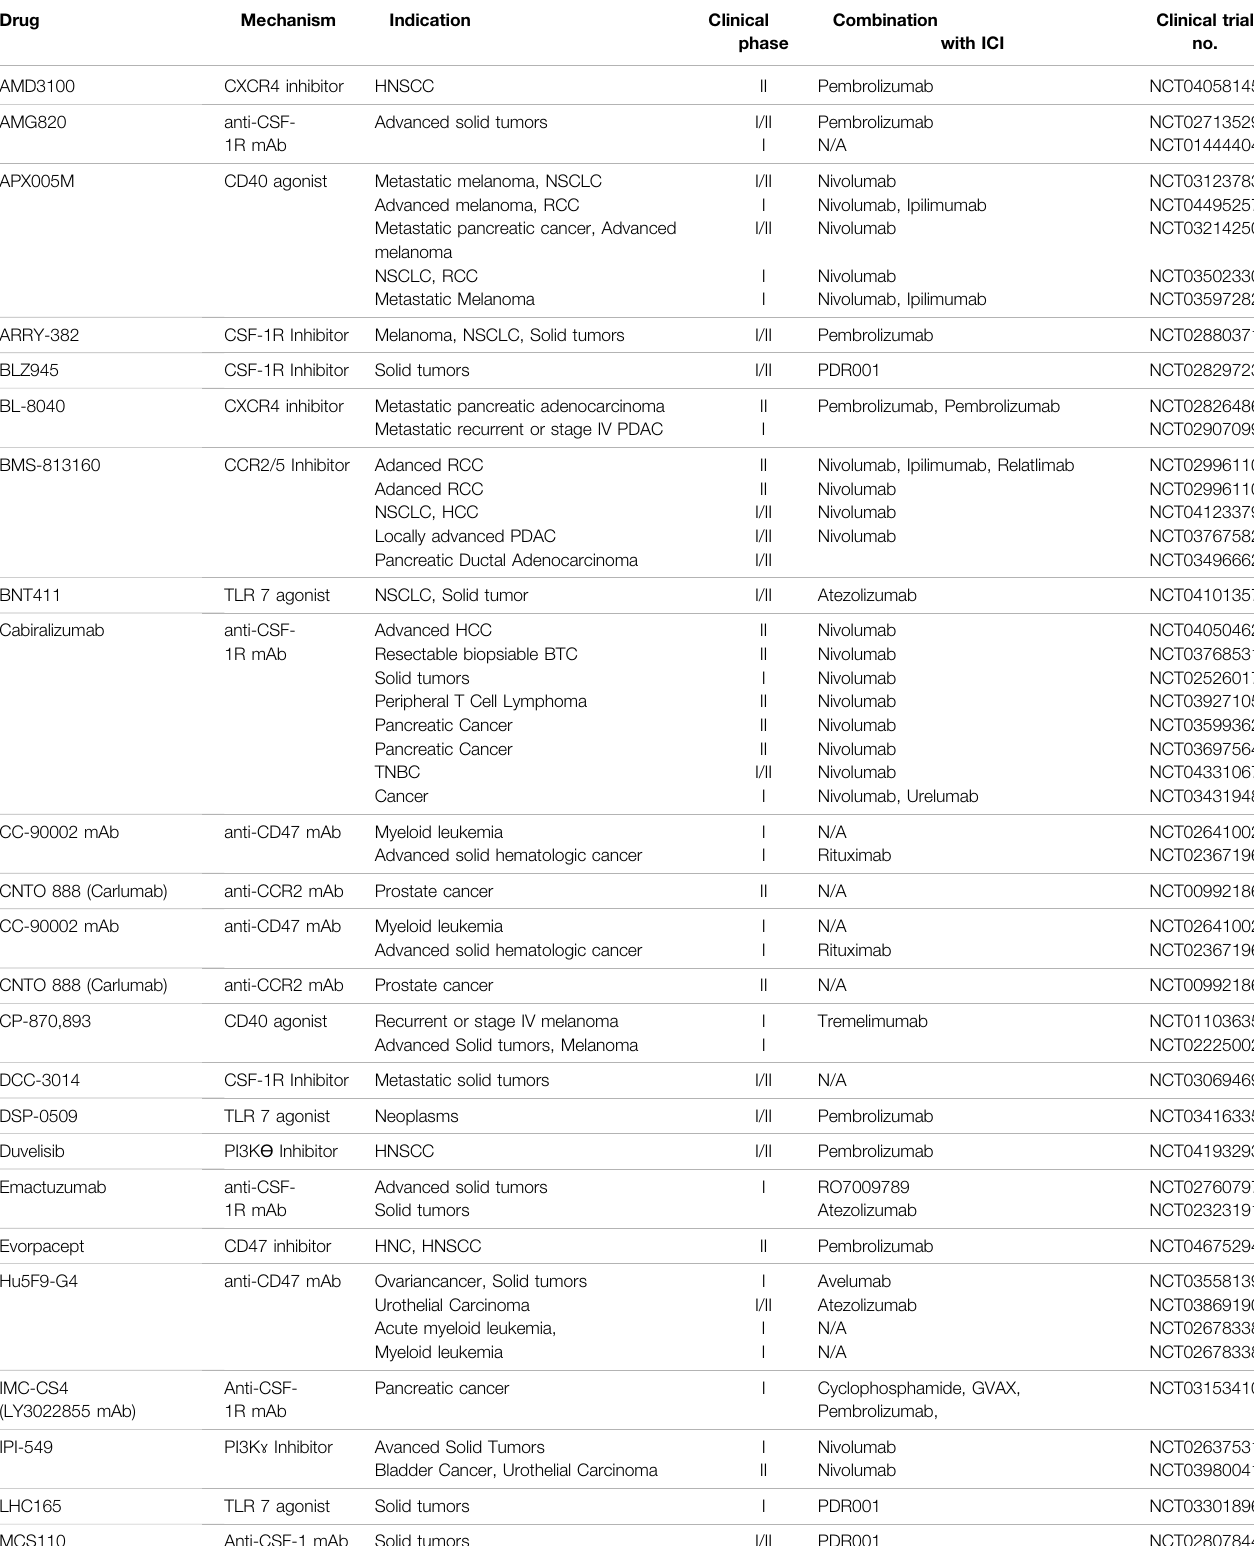
TABLE 2 | Tumor-associated Macrophage targeted